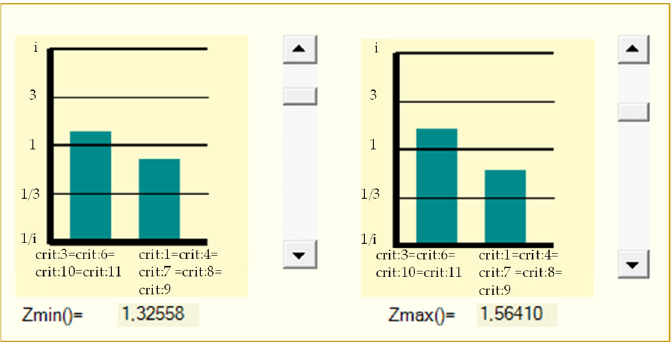
Figure 3. Assessment of the Z min and Z max between the first and second class. Table 5. Estimation of